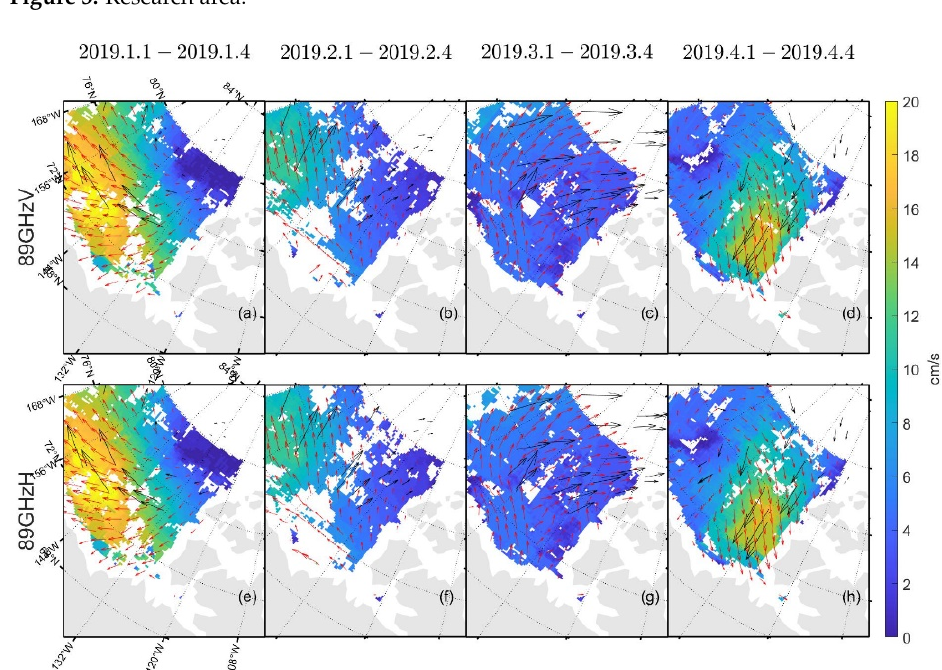
Figure 4. Schematic diagram of the movement of sea ice retrieved by FY-3D/MWRI T b data at 89 GHz. Figure ( a – d ) show sea ice motion retrieved from FY-3D/MWRI T b data at 89 GHz with V polarization. Figure ( e – h ) show sea ice motion retrieved from FY-3D/MWRI T b data at 89 GHz with H polarization. Table 3. Error-related statistics of the retrieved sea ice motion from FY-3D/MWRI T b data at 89 GHz in the Beaufort